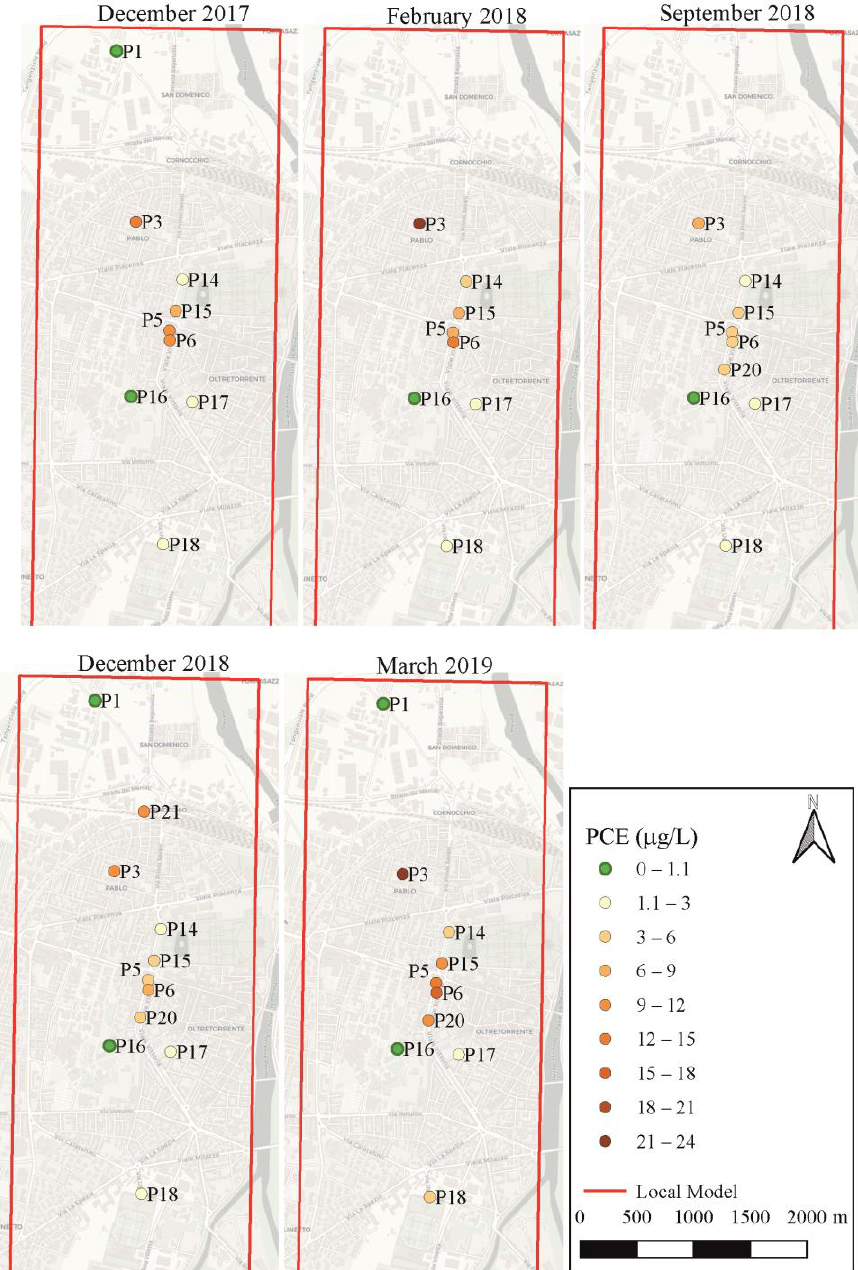
Figure 7. PCE concentrations. Observed at the monitoring wells during five monitoring cam- paigns.